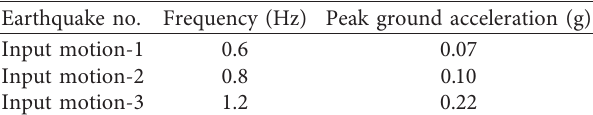
Figure 7: Soil-pile-raft system: (a) plan view of the model, (b) cross section along the plane (all dimensions are in meters). Table 3: Properties of